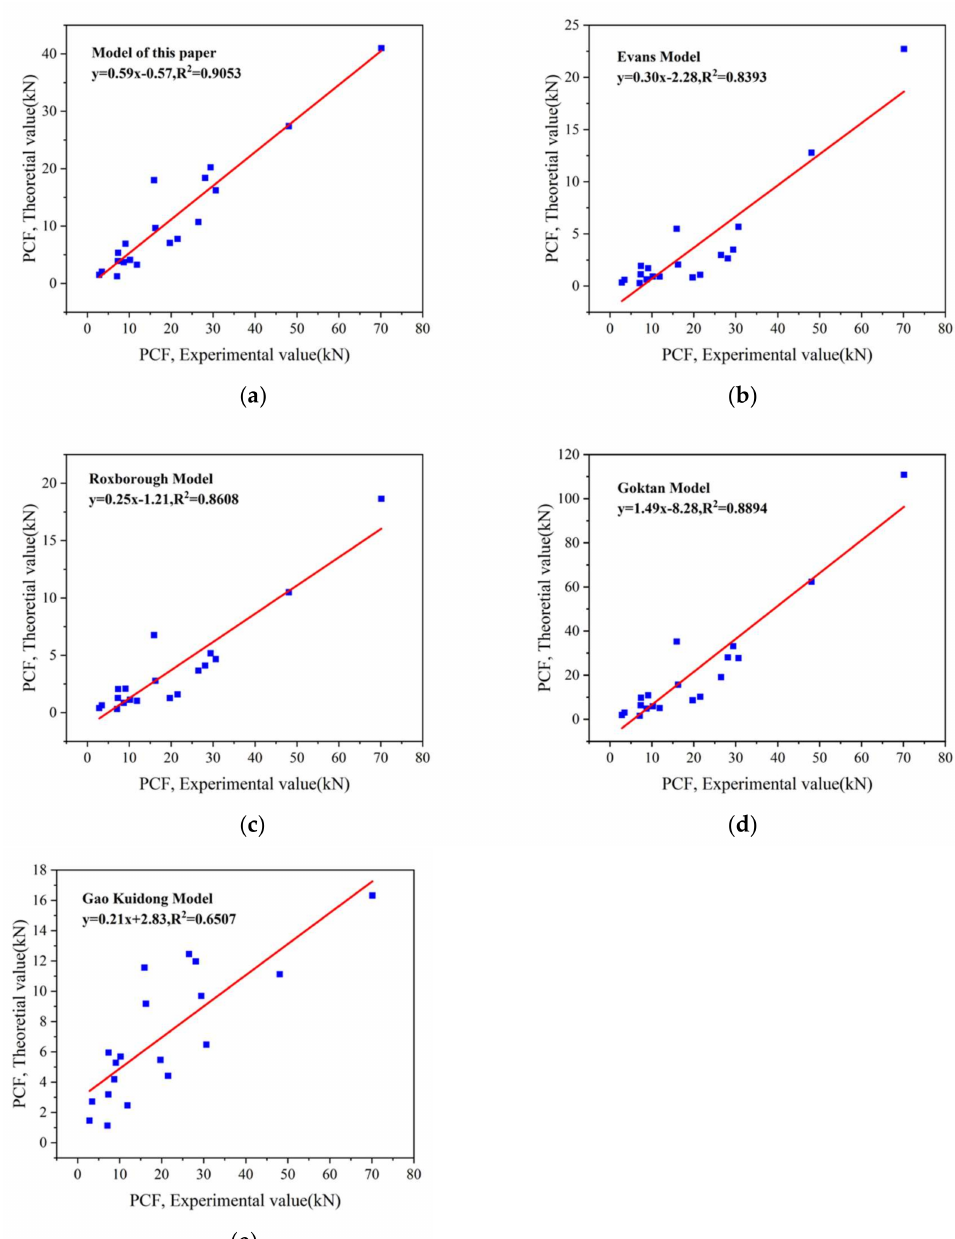
Figure 5. The relationship between theoretical model calculation results and experimental results for the first prediction performance analysis. ( a ) Theoretical model of peak cutting force in this paper; ( b ) Evans model; ( c ) Roxborough model; ( d ) Goktan Semi-empirical model; ( e ) Gao Kuidong